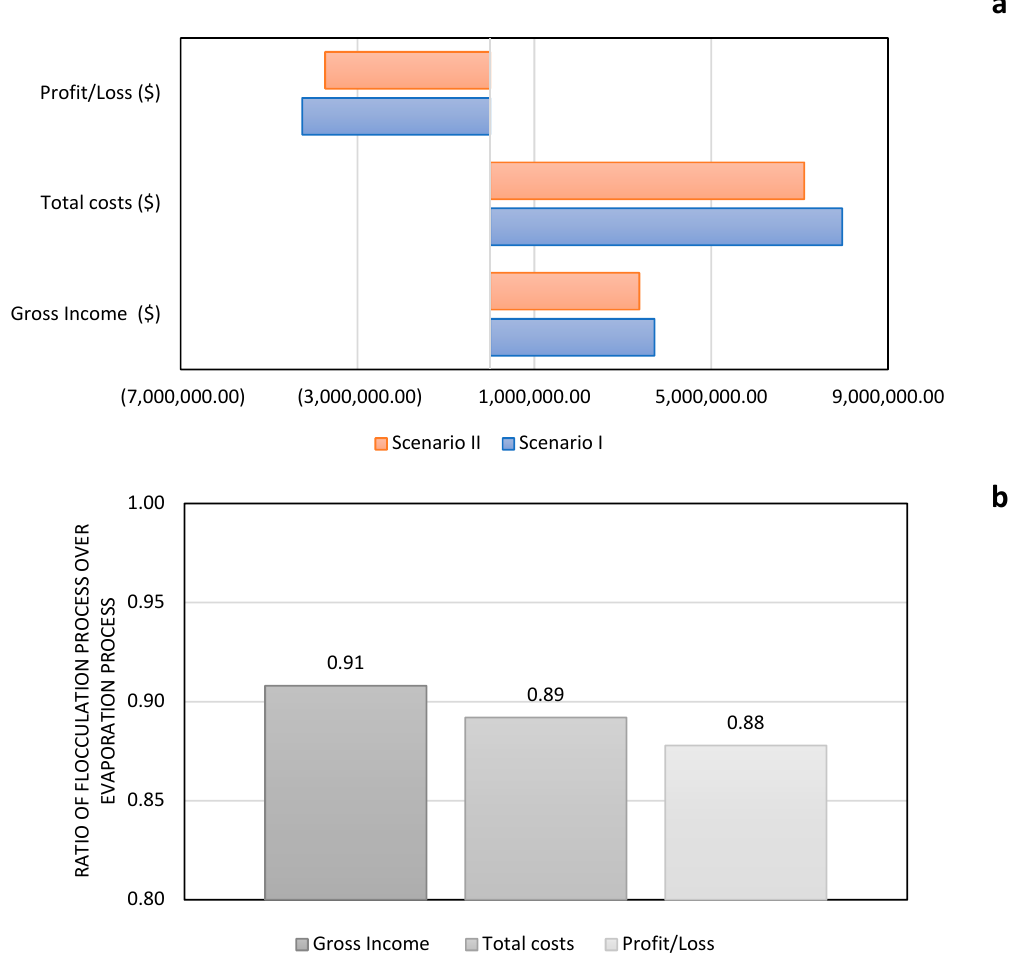
Figure 6. ( a ) Profitability of an ethanol plant, considering conventional ethanol production (Scenario I) and a flocculation system (Scenario II). The numbers between parentheses are negative. ( b ) Ratio of the profitability of Scenario II to Scenario I.